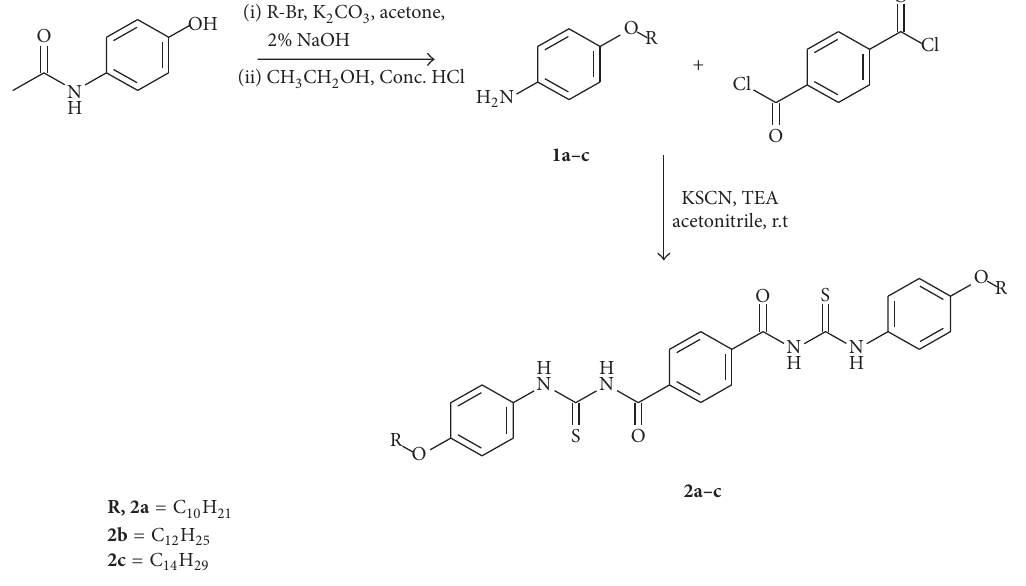
Scheme 1: Synthesis of bis(thiourea)